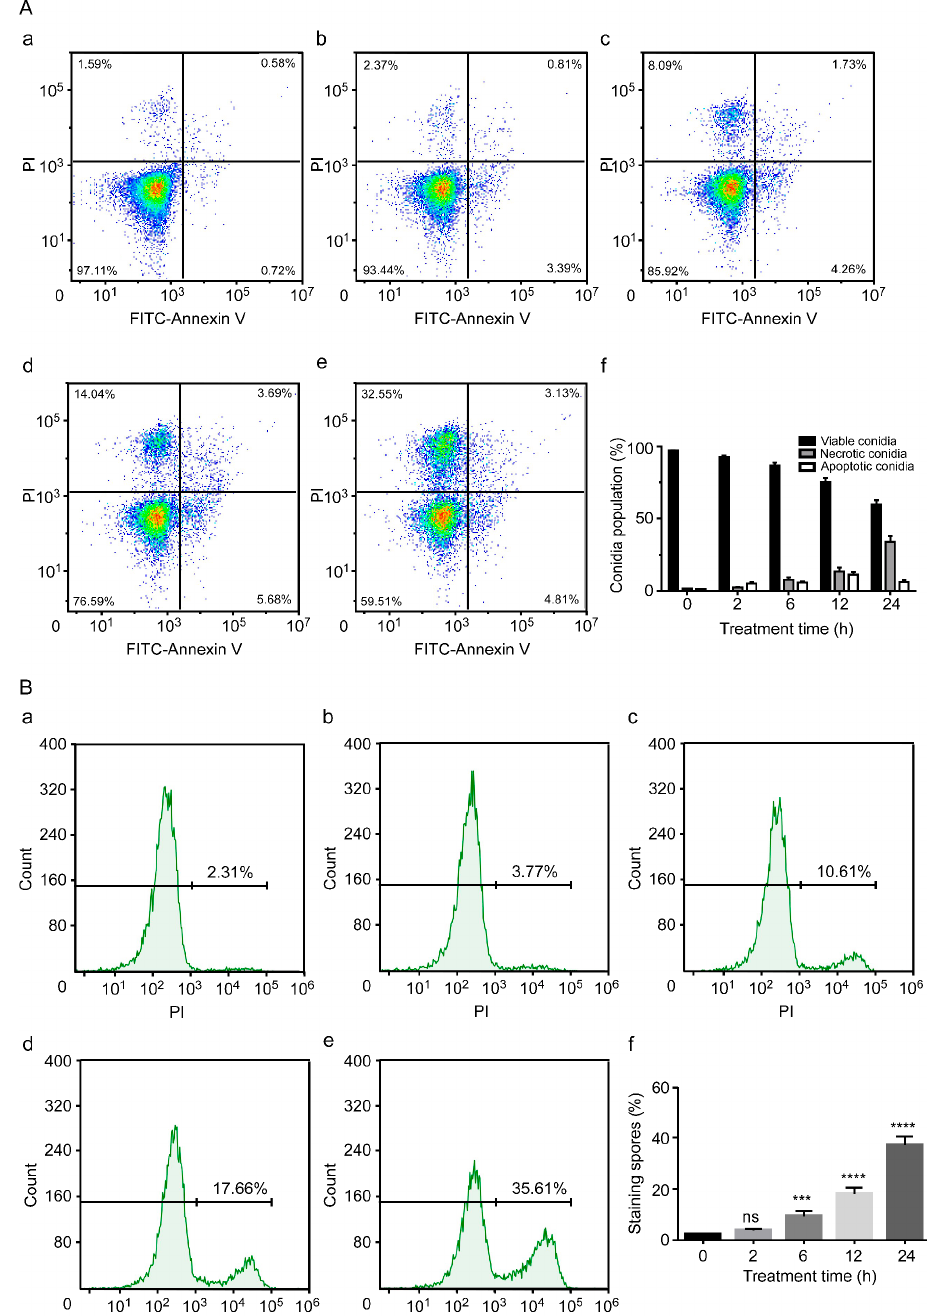
Figure 3. The conidial necrosis of Vd 991 was analysed by flow cytometry after treatment with C17 mycosubtilin. ( A ). The spore population of Vd 991 after treatment with C17 mycosubtilin at the IC50 concentration at different times by annexin V-FITC/PI double staining. a, Untreated Vd 991 spores (control); b–e, Vd 991 spores treated for 2 h, 6 h, 12 h, and 24 h, respectively; f, summary of spore population data. Each dot represents a cell, and the color represents the cell density ( B ). Vd 991 spores treated with C17 mycosubtilin at the IC50 concentration at different times by PI staining. a, Untreated Vd 991 spores (control); b–e, Vd 991 spores treated for 2 h, 6 h, 12 h, and 24 h, respectively; f, statistical diagram of spore staining rate at different treatment times. Statistical analysis in this figure is based on one-way ANOVA. Values are mean ± SD, where n ≥ 3; ns means no significant difference, *** means significant difference at p < 0.001, and **** means significant difference at p <